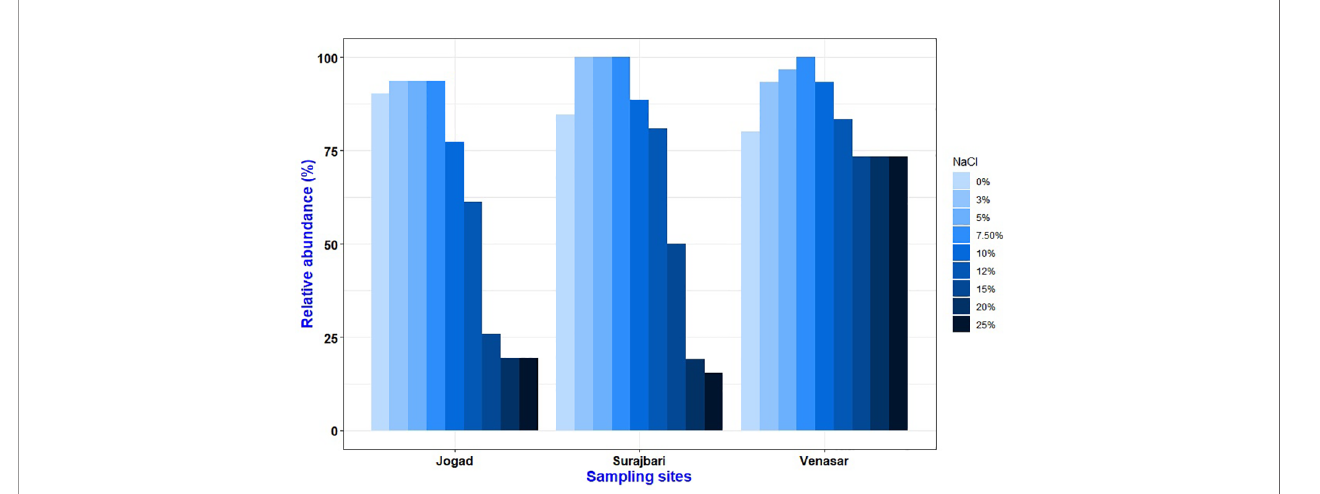
FIGURE 2 | Comparative pro fi le showing effect of NaCl concentration (%, w/v) on growth of isolates from Surajbari, Venasar, and Jogad study